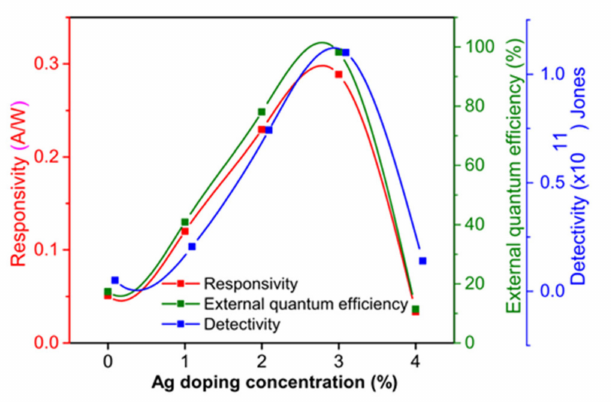
Figure 7. The variations of the responsivity ( R ), specific detectivity ( D *) and external quantum efficiency (EQE) with respect to different Ag doping